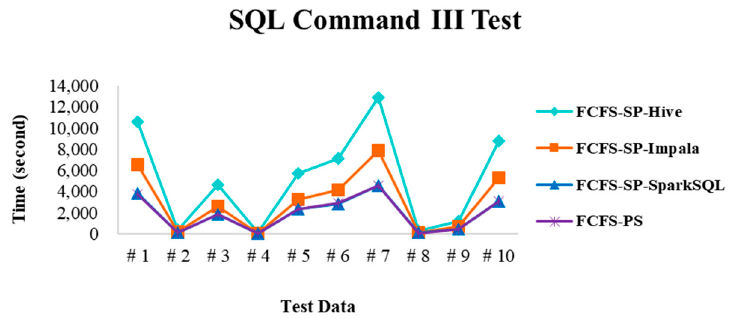
Figure 27. Execution time of SQL command III in test environment III. Appl. Sci. 2018 , 8 , x FOR PEER REVIEW